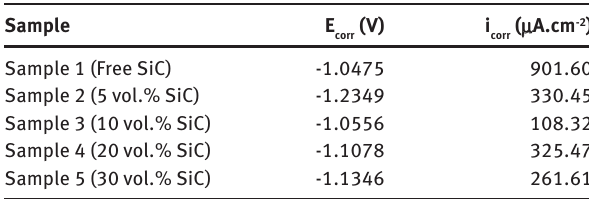
Table 1: Electrochemical corrosion parameters of composites in 3.5% NaCl solution.